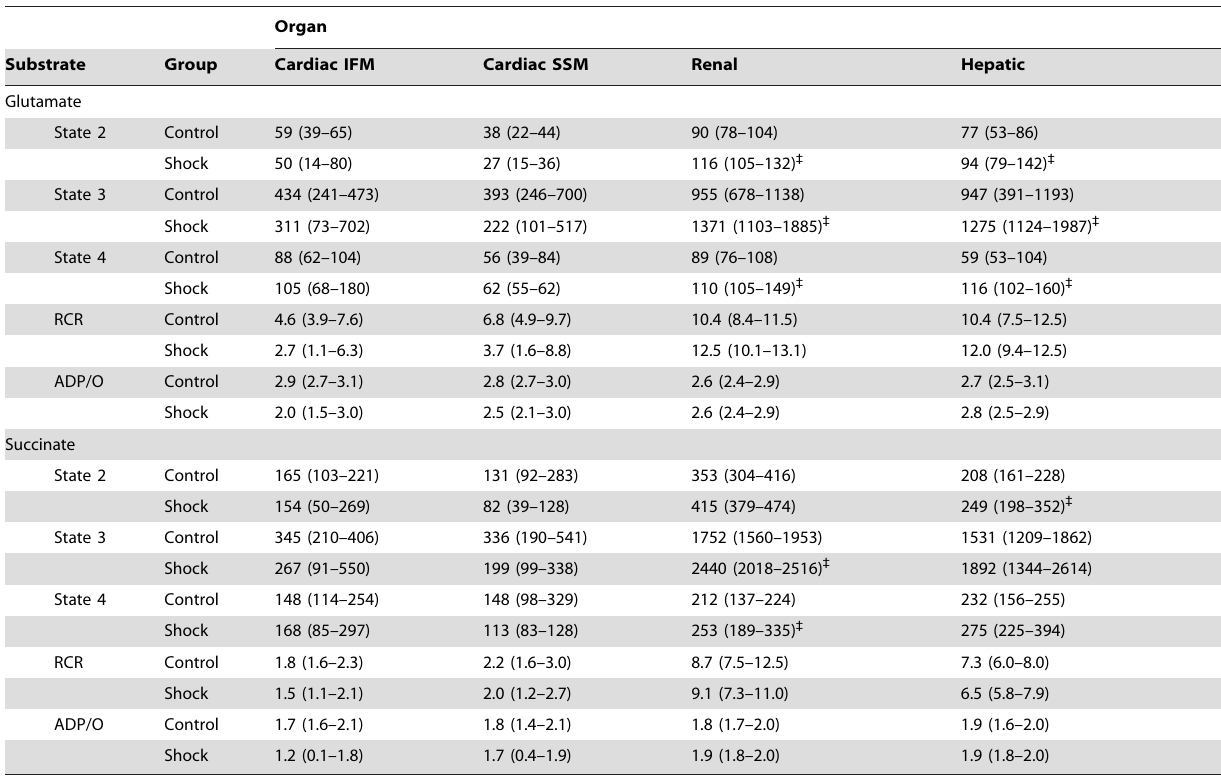
Table 1. Mitochondrial Respiratory